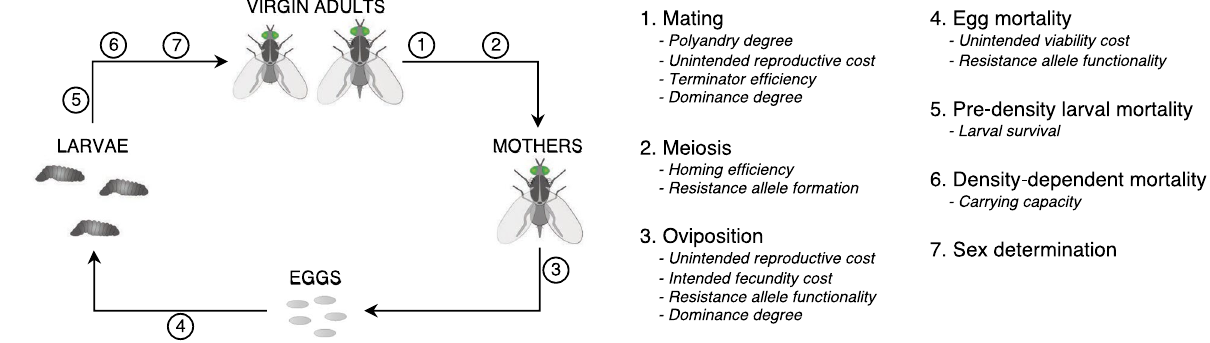
Figure 2. Model stages and steps across a generation. Major invoked parameters are shown per step. (1) Female and male virgin adults mate randomly giving rise to mothers, i.e., inseminated females. Females may mate more than once. Male mating success of drive-carrying males is reduced by unintended drive effects, and terminator males may kill the female during mating. (2) For simplicity, meiosis and homing conversion are only modeled for surviving mothers and mating males. (3) Each mother produces a clutch of eggs where the expected number of eggs may be reduced for drive-carrying mothers. (4) Eggs have a probability of dying before reaching the larval stage, which may be higher for drive-carrying eggs. (5) Larvae have a probability of dying right after hatching. (6) Then, larvae are subject to density-dependent mortality. (7) Surviving larvae result in virgin adults, and sex is randomly determined.